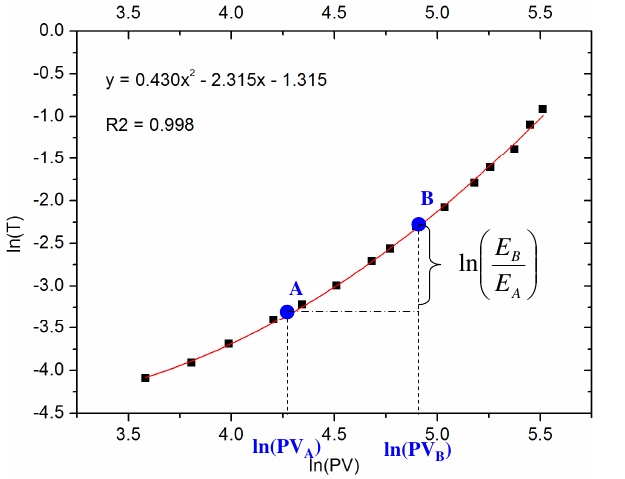
Fig. 3. Locations of the target and camera sites for daytime and nighttime field tests. Red camera icons indicate the near and far camera sites where the pictures were taken during daytime. White camera icons indicate the near and far camera sites for nighttime tests. Pictures of the targets for daytime and nighttime tests are shown in the smaller images at the upper right corner and lower left corner, respectively.